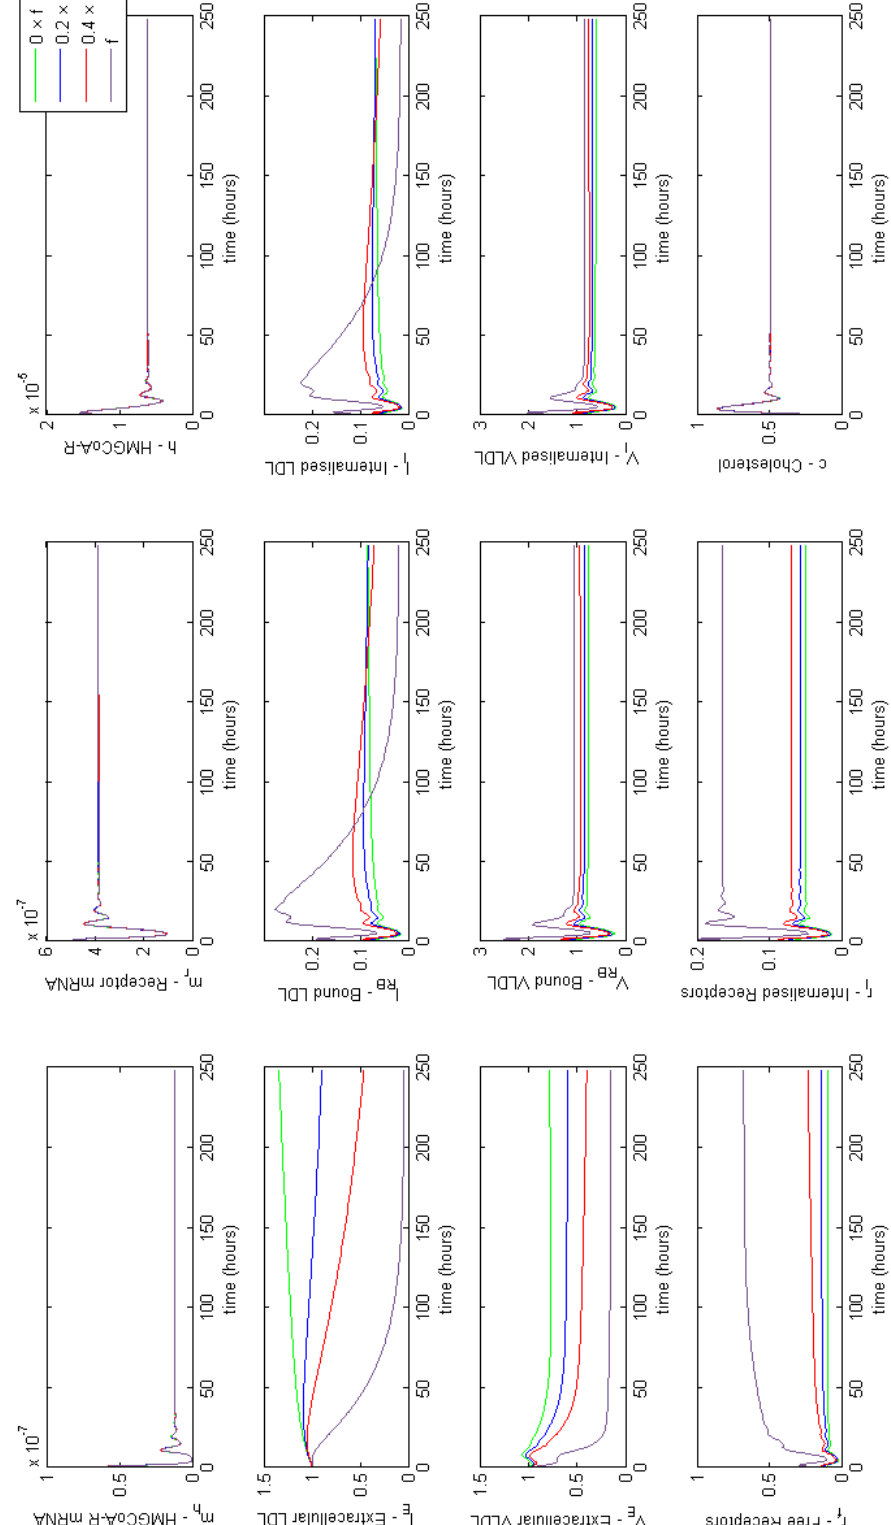
Figure A4. Familial Hypercholesterolaemia Class V; receptors are not recycled properly, affecting model parameter f . Results show a decrease in free and internalised receptors, significantly affecting extracellular concentrations of both LDL and